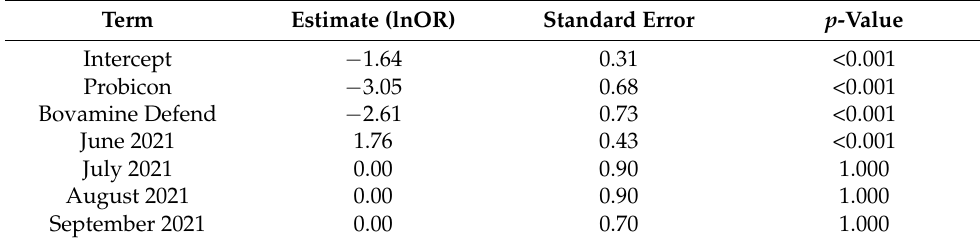
Table 3. Results of the GEE analysis for Salmonella prevalence.